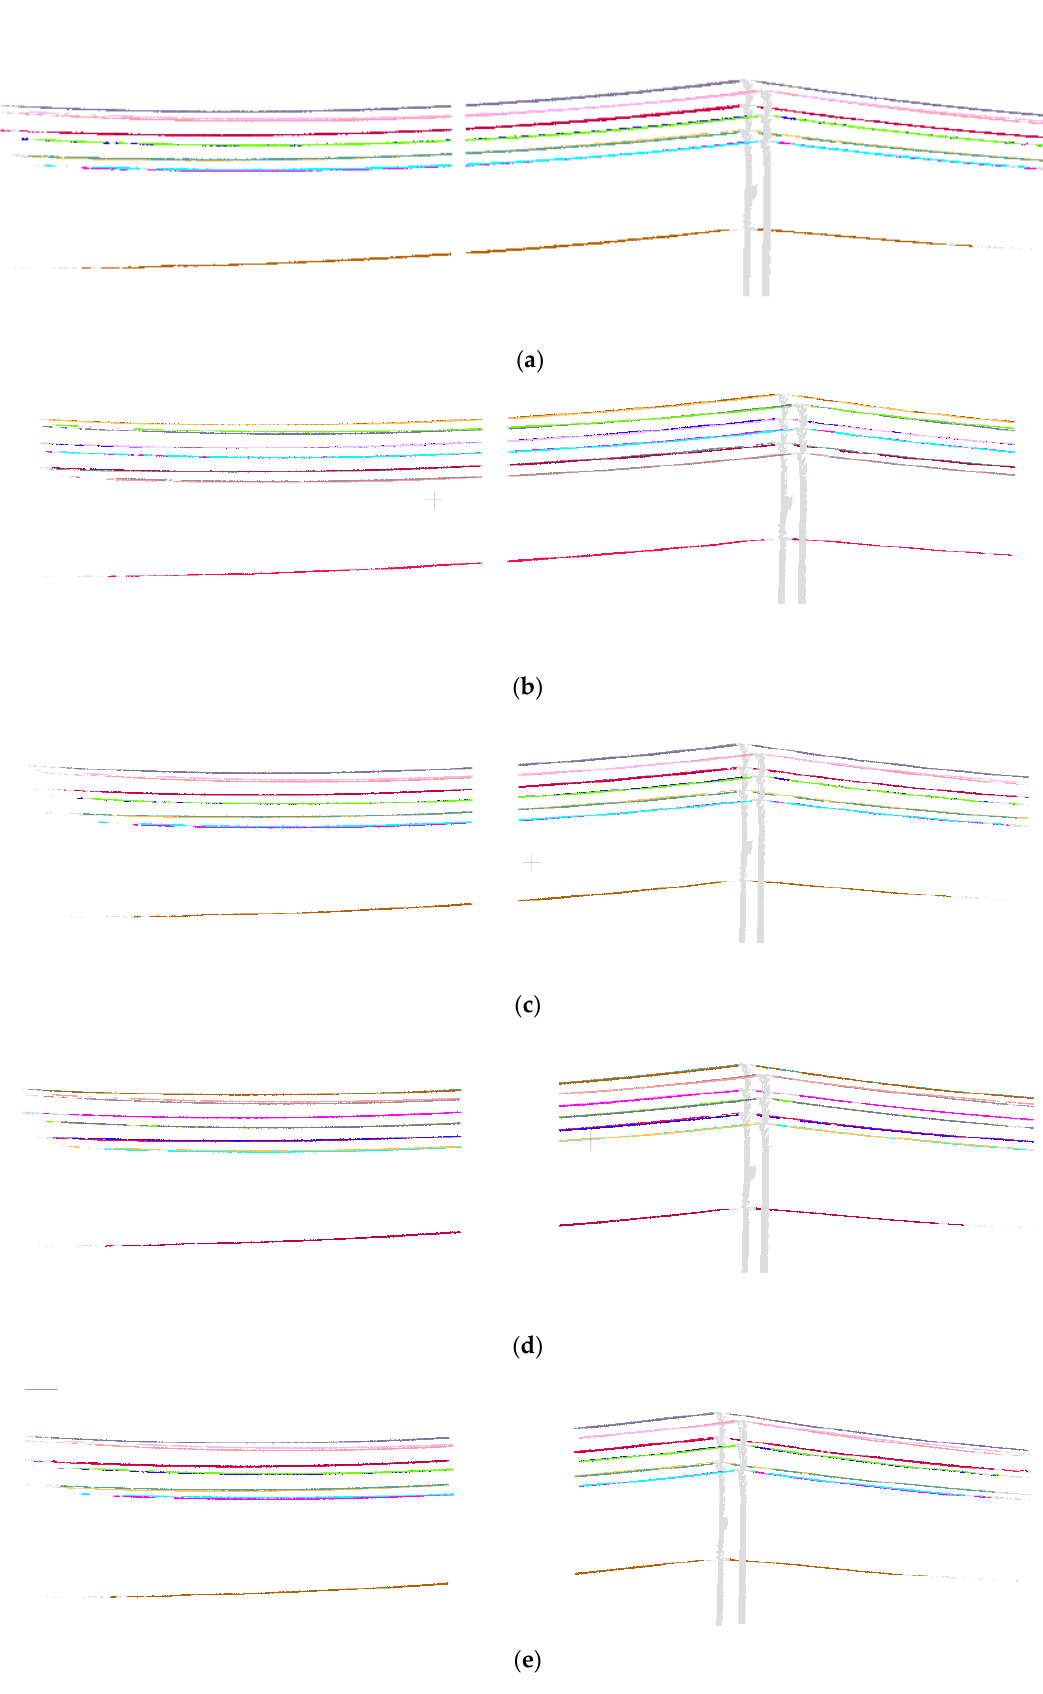
Figure 12. Robustness test. ( a ) Individual powerlines extraction with segment width s l . ( b ) Individual powerlines extraction with segment width 2 s l . ( c ) Individual powerlines extraction with segment width 4 s l . ( d ) Individual powerlines extraction with segment width 8 s l . ( e ) Individual powerlines extraction with segment width 12 s l